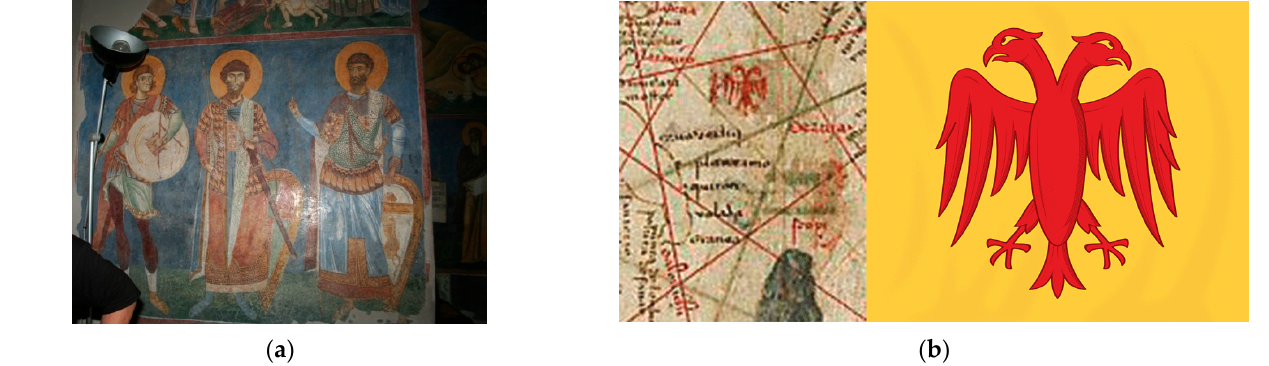
Figure 1. ( a ) Right wall of the entrance of the main sanctuary of monastery church of St Pantelejmon in Nerezi, Skopje; ( b ) Angelino Dulcert map of 1339, and reconstruction by Stamatovski. ( b ) Angelino Dulcert map of 1339, and reconstruction by